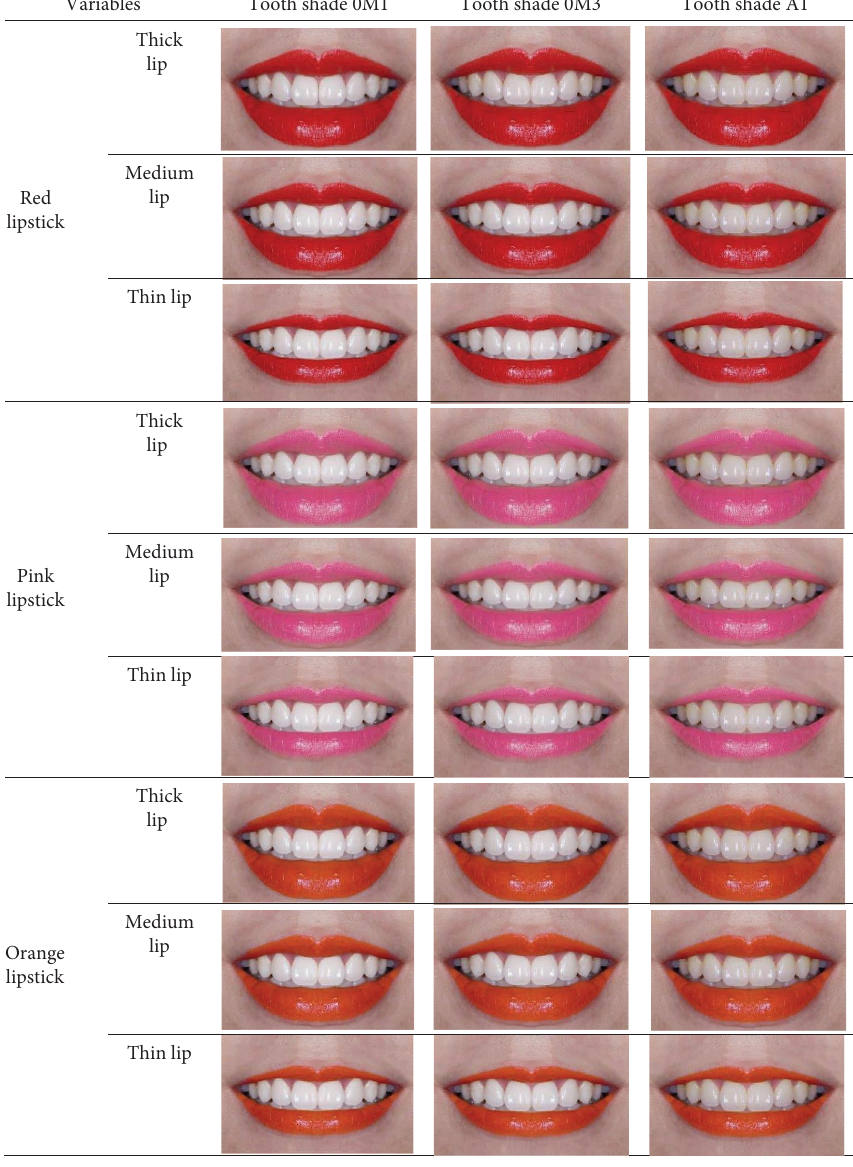
Figure 1: Te photographic questionnaire with 27 photographs of various lip thicknesses, lipstick shades, and tooth